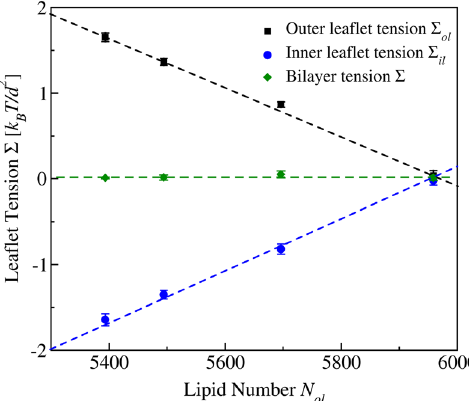
Fig.2|Stressasymmetryoftensionlessbilayersforsphericalnanovesicleswith volume ν = ν 0 : lea fl et tensions Σ ol (black squares) and Σ il (blue circles) of the outer and inner lea fl et as a function of the lipid number N ol assembled in the outer lea fl et which implies the lipid number N il =10,100 − N ol in the inner lea fl et. For 5400 ≤ N ol <5963, the outer lea fl et is stretched by the positive tension fl et is compressed by the negative tension Σ fl et Σ ol whereas the inner lea il . Both lea tensions vanish for N ol =5963. In all cases, the bilayer tension Σ = Σ ol + Σ il (green diamonds)isclosetozero.Thenumericalvaluesforthevolume ν 0 aswellasforthe lea fl etandbilayertensionsareprovidedinTableS1.Eachdatapointrepresentsthe mean value over n =15 statistically independent samples obtained from three replicated simulations. Each error bar is the standard error of the mean